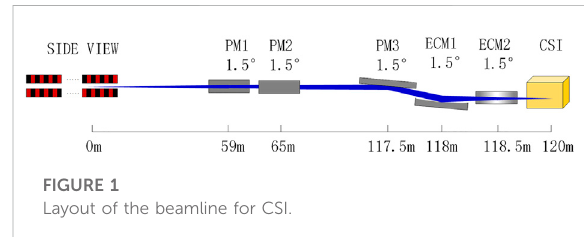
FIGURE 1 Layout of the beamline for